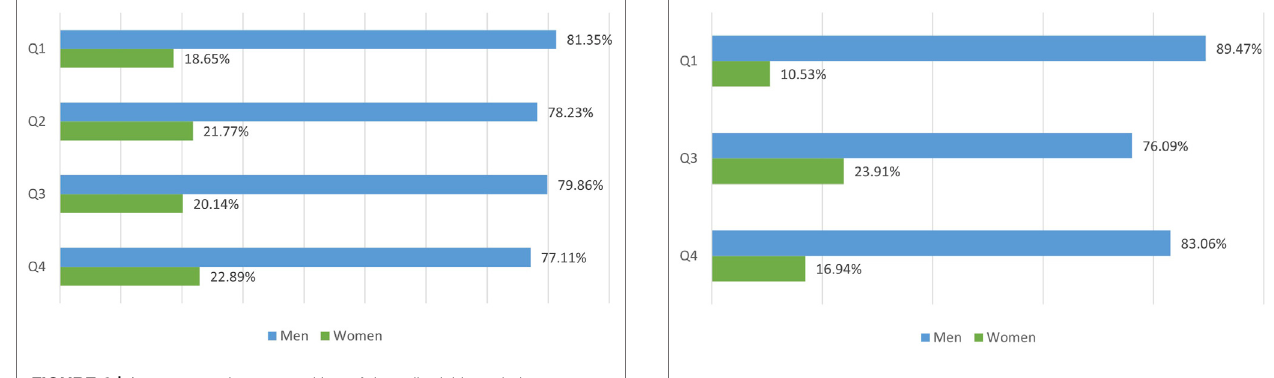
FIGURE 2 | Average gender composition of the editorial boards by quartile ranking of 47 journals classi fi ed within the category of “ Geology ” in 2020 and included in Science Citation Index Expanded ™ .